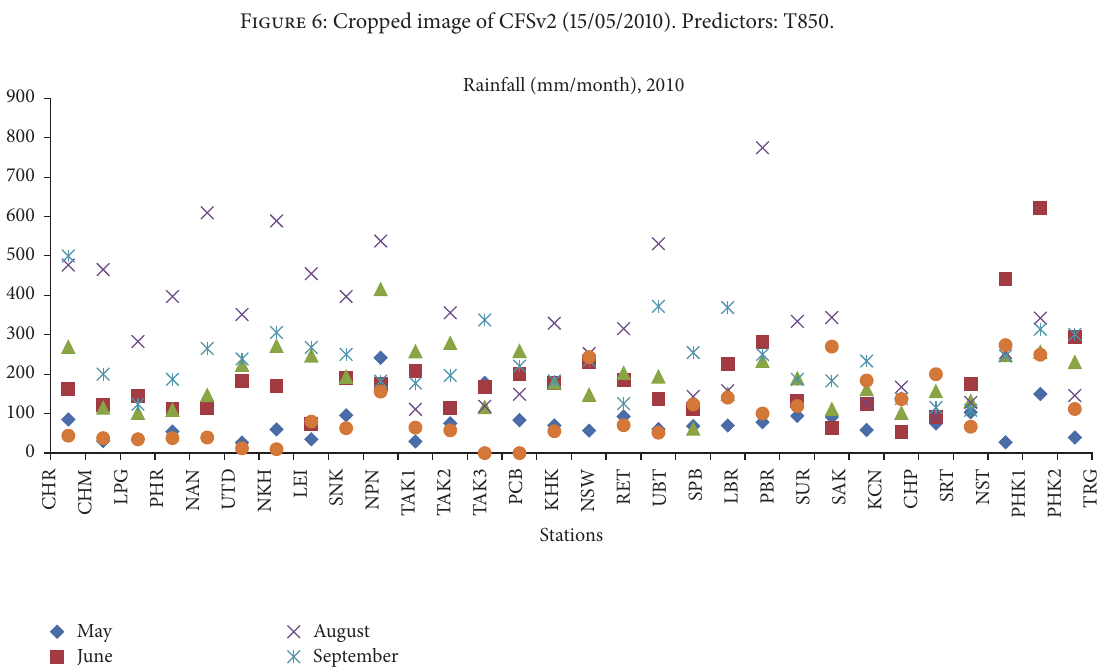
Figure 6: Cropped image of CFSv2 (15/05/2010). Predictors: T850.